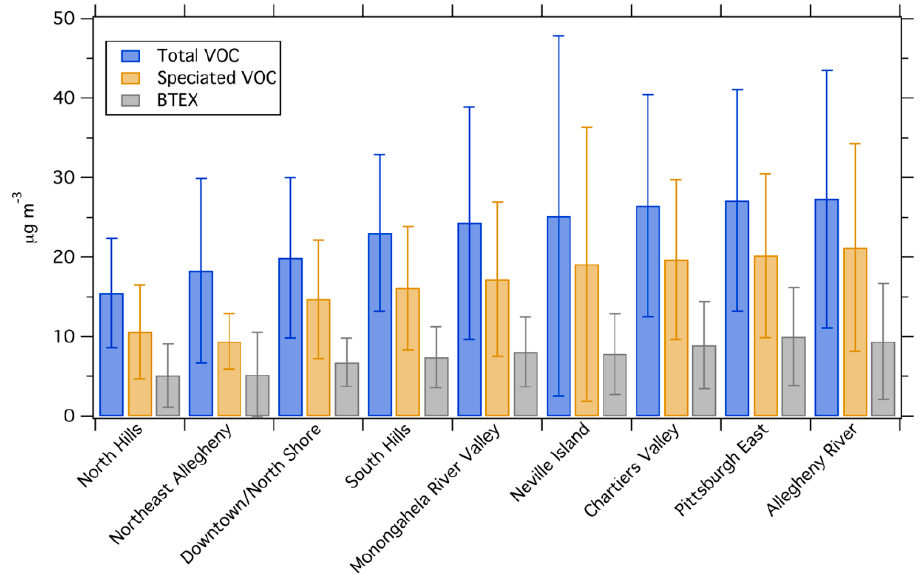
Figure 4. The average concentration of total VOC, speciated VOC (sum of 13 species identified in Figure 2), and BTEX for each group of sites, ranked based on the order of total VOC concentrations. Error bars show one standard deviation.